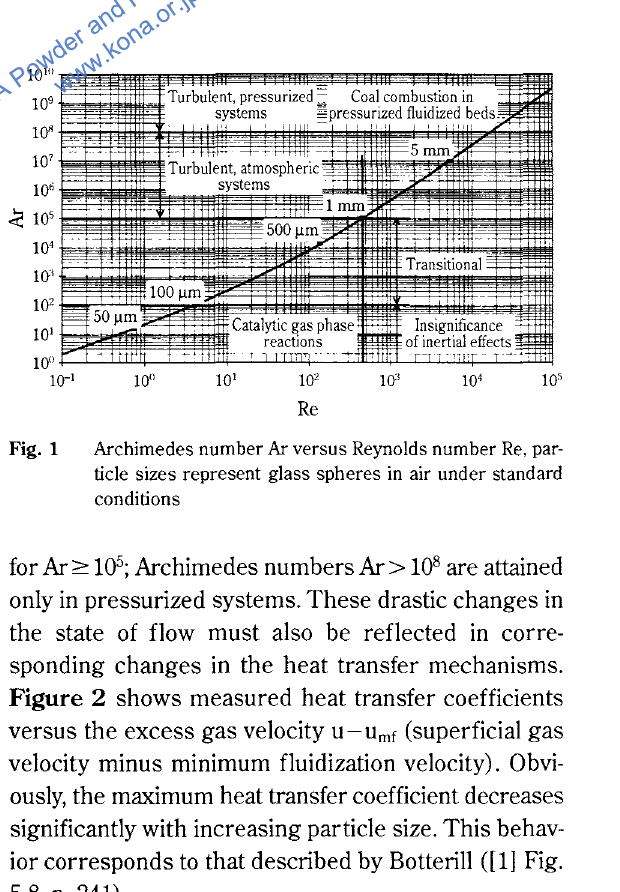
observation of observation of the sidewall immersed tube Fig.3 Experimental set-up for observing particle motion close to solid surfaces. solid surfaces is quite simple. Transparent side walls allow direct observation of particle migration (Fig. 3, right side). The observation of particle motion close to immersed surfaces (Fig. 3, left side), e.g. heat exchanger tubes inside a fluidized bed, is realized by using a periscopic mirror arrangement installed in a dummy